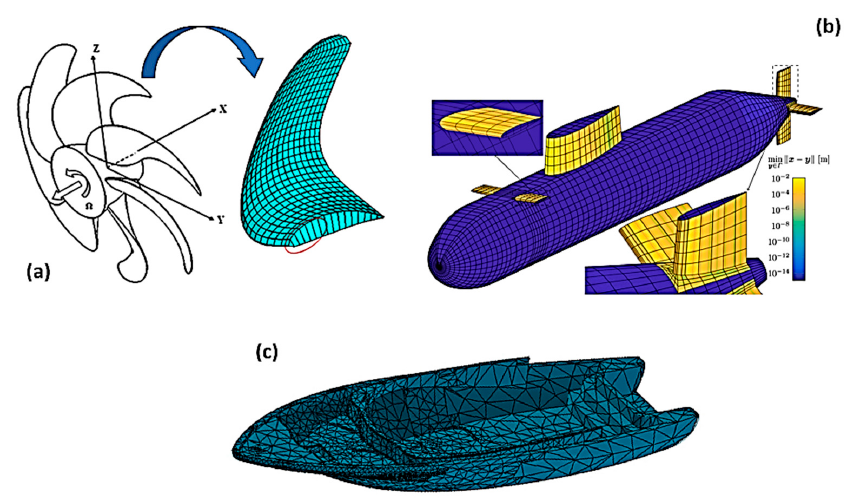
Figure 42. Some applications of FEM in composites in the naval sector: ( a ) propellers. Reproduced with permission [303], ( b ) submarines. Reproduced with Creative Common License [267] and ( c ) ships.